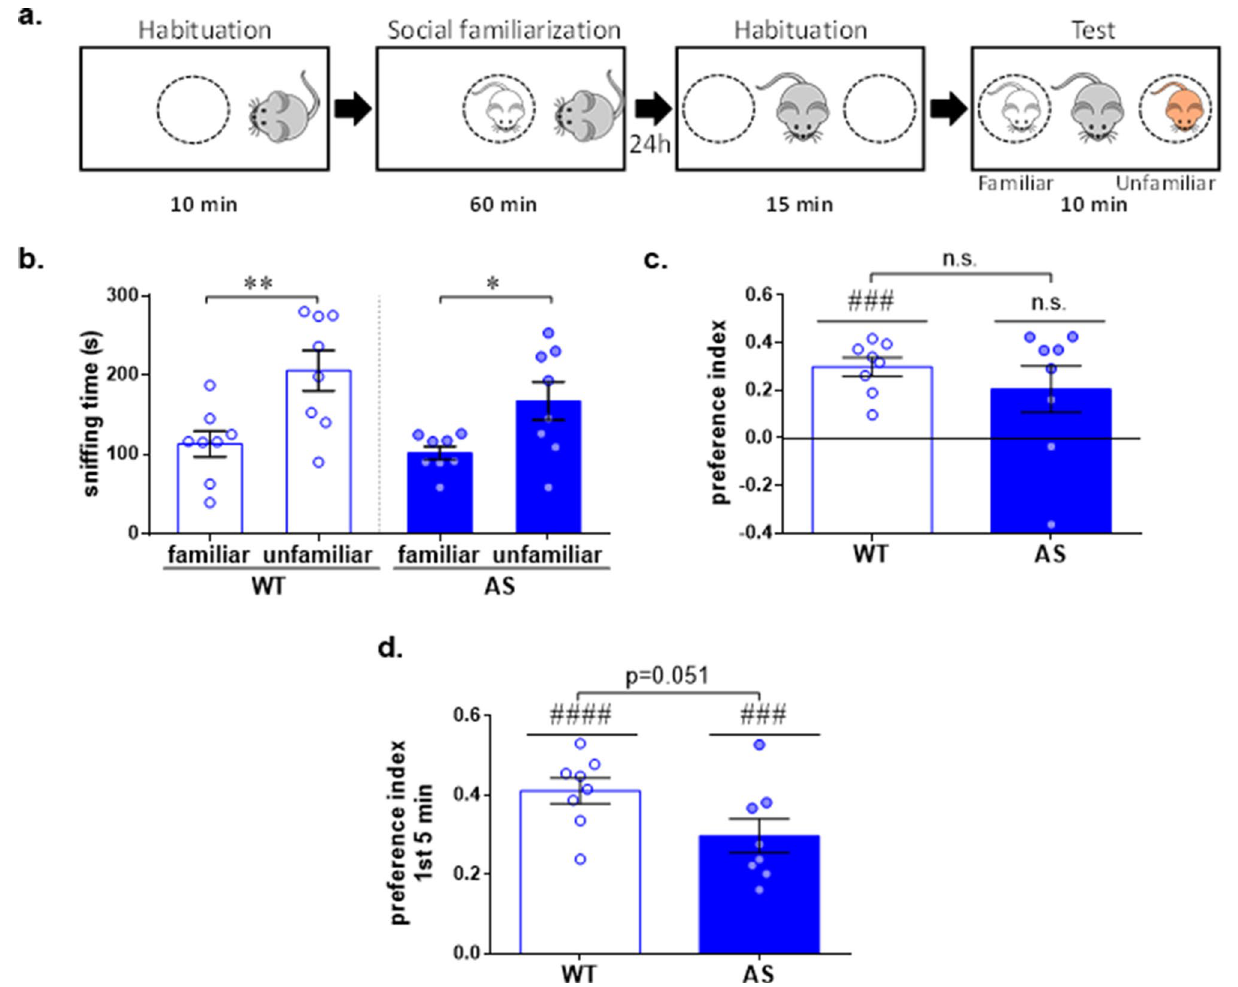
Figure 4. AS model mice display a minor alteration in long-term social discrimination memory (SDM). ( a ) Illustration of long-term SDM test. ( b ) Time spent sniffing the familiar mouse and the unfamiliar mouse, 24 h after the exposure to the familiar mouse. WT and AS mice similarly spend more time sniffing the unfamiliar mouse than the familiar mouse. ( c ) Long-term SDM preference index (PI) towards the unfamiliar mouse. WT mice display positive long-term SDM PI, while AS mice do not. However, the long-term SDM PI does not differ between genotypes. ( d ) Long-term SDM PI during the first 5 min of the test. Both genotypes showed a positive PI during the first 5 min, yet WT mice exhibit a trend for a higher PI compared to AS littermates. Bar graphs represent mean ± SEM. N = 8 mice per each group (WT and AS). * p < 0.05, ** p < 0.01; ### p < 0.001, #### p < 0.0001, n.s. = non-significant, represent differences from the chance level; ITI = inter-trial AS model mice display a minor alteration in long-term social discrimination. Previous studies in AS model mice have reported profound deficits in some of the long-term memory paradigms 23–25,35 . How- ever, long-term social memory has never been studied in AS mice. Owing to the fact that AS mice demonstrate typical social discrimination ability in social novelty test, we modified this paradigm in order to assess their long-term social discrimination memory (SDM). For that, we introduced a pre-exposed stimulus mouse (24 h post-exposure) in parallel to a novel stimulus mouse (Fig. 4a). Both WT and AS mice exhibited a more extensive investigation of the unfamiliar stimulus compared to the familiar one, with no difference between the genotypes [F (1,14) = 1.12, p = 0.31 and F (1,14) = 28.65, p < 0.001 for genotype and sniffing time effects respectively, in 2way RM ANOVA; Bonferroni’s post-hoc test comparisons: t (14) = 4.43, p < 0.01, t (14) = 3.14, p < 0.05 for WT and AS respec- tively] (Fig. 4b). This was reflected in a comparable PI for long-term SDM between WT and AS mice [t (14) = 0.89, p = 0.39 in unpaired t-test] (Fig. 4c), although only the WT mice displayed long-term SDM PI that was signifi- cantly higher than the chance level [t (7) = 7.71, p < 0.001, t (7) = 2.1, p = 0.07 for WT and AS respectively in one sample t-test]. Notably, the long-term SDM PI during the first 5 min was significantly different from the chance level in both genotypes [t (7) = 12.79, p < 0.0001, t (7) = 6.97, p < 0.001 for WT and AS respectively in one sample t-test], but the PI of the WT showed a strong trend for being higher than that of the AS [t (14) = 2.13, p = 0.051 in unpaired t-test] (Fig. 4d). Taken together, these findings suggest that AS mice demonstrate a long-term social discrimination ability along the first 5 min of the test, yet not comparable to the level of their WT littermates.